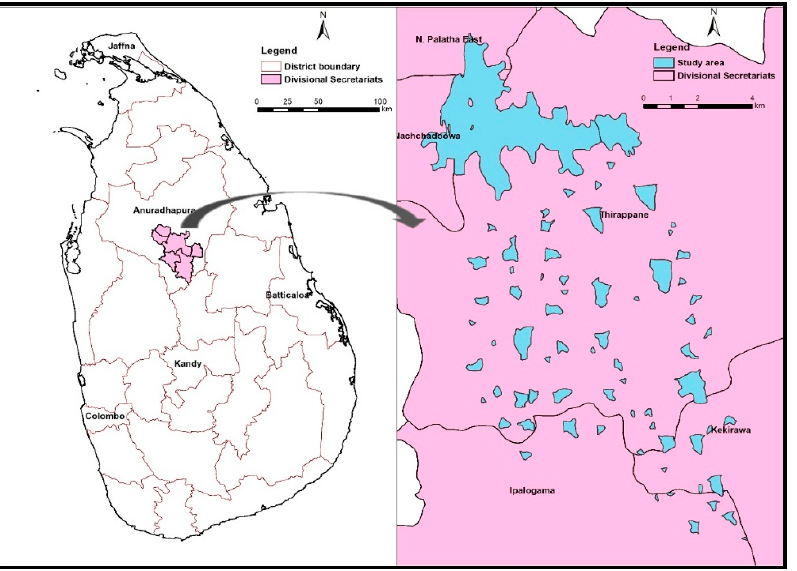
Figure 1. Location of the tank cascade system (study area) showing relevant administrative divisions. The TCS, which has been sustained for centuries, is presently confronted with chal- lenges from aquatic plant invasion, which is particularly linked to impacts of climate change. At present, a majority of the cascade tanks are covered with some of the world’s worst invasive plants: S. molesta and E. crassipes. Salvinia molesta and E. crassipes were introduced to Sri Lanka as early as 1930 and 1905 respectively and soon dispersed to the water bodies across the country [11,41]. By the early 1980s, S. molesta and E. crassipes had infested the tanks system in the dry zone, where the majority of the tanks were entirely covered with a thick growth